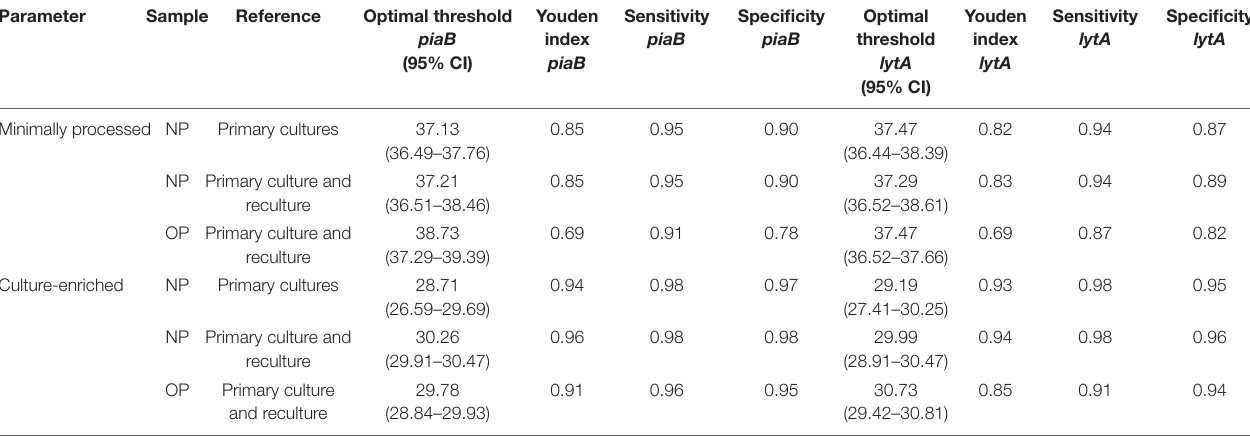
TABLE 2 | Optimal qPCR cycle threshold C q and corresponding parameters for Streptococcus pneumoniae carriage detection in nasopharyngeal ( n = 1,549) and oropharyngeal ( n = 319) samples.